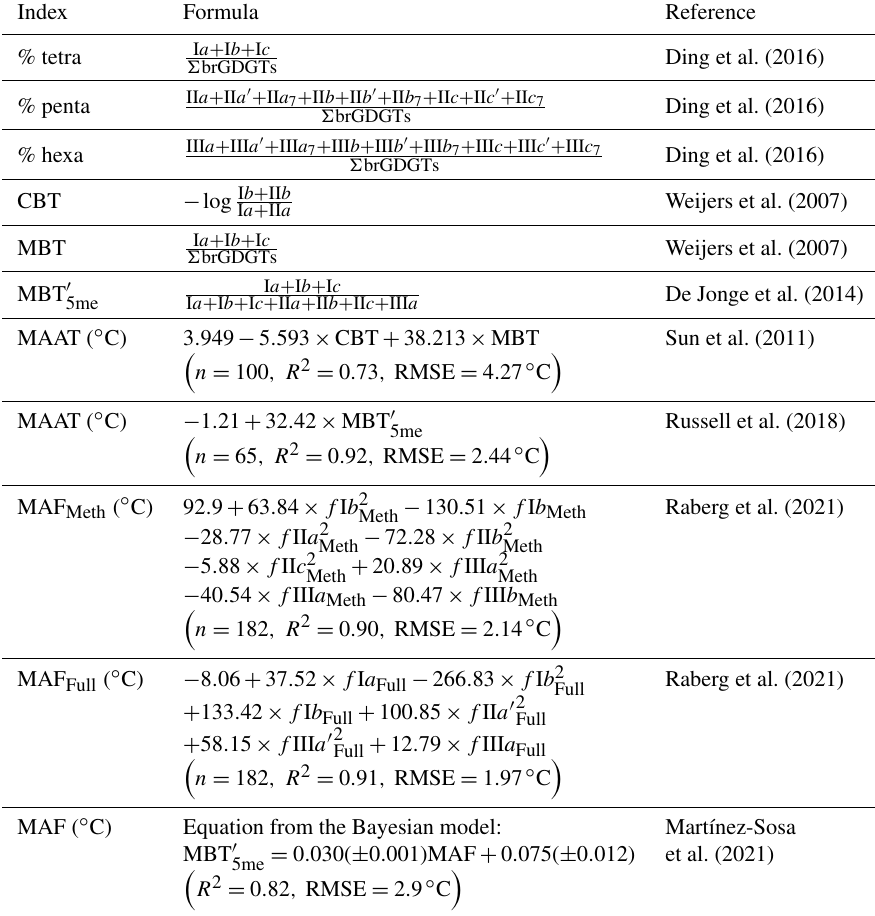
Table 1. Synthesis of the formulae for the main brGDGT indices. For a full explanation of MAF Meth and MAF Full , see Raberg et al. (2021). For more information about the Bayesian statistics, see Martínez-Sosa et al. (2021) and references